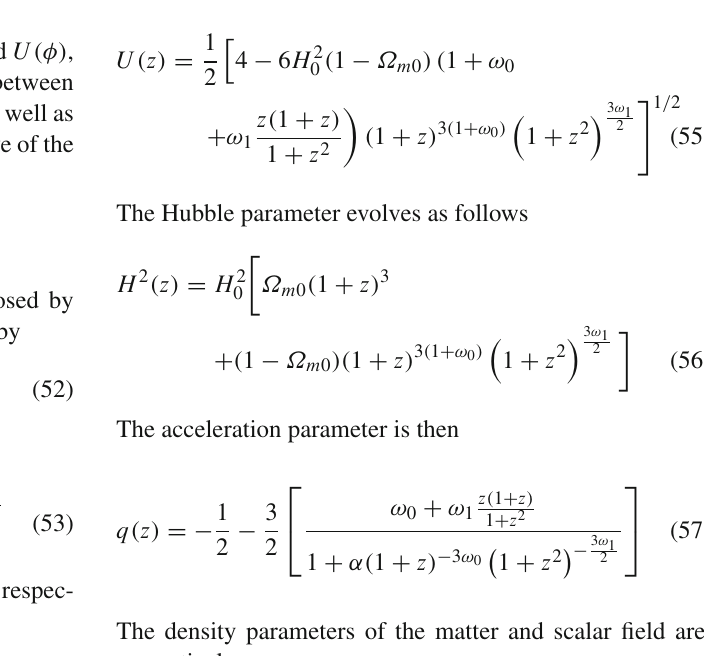
Fig. 2 a Plot of φ as a function of z . b Plot of V (solid curve) and U (dashed curve) as a function of φ . c Plot of q as a function of z . d Plot of Ω φ (solid curve) and Ω m (dashed curve) as a function of z . This is for linear parametrization, with Ω = 0 . m 0